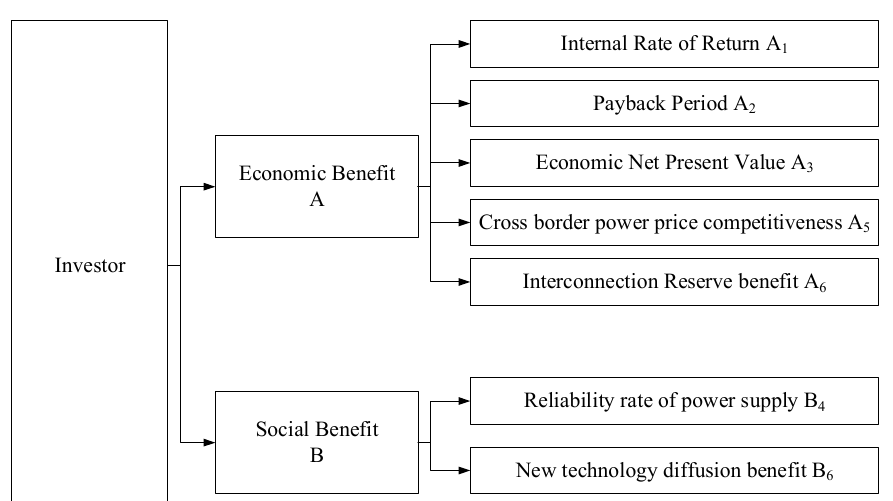
Figure 2. The comprehensive benefit evaluation index system of transnational power networking projects based on investors’ perspective.